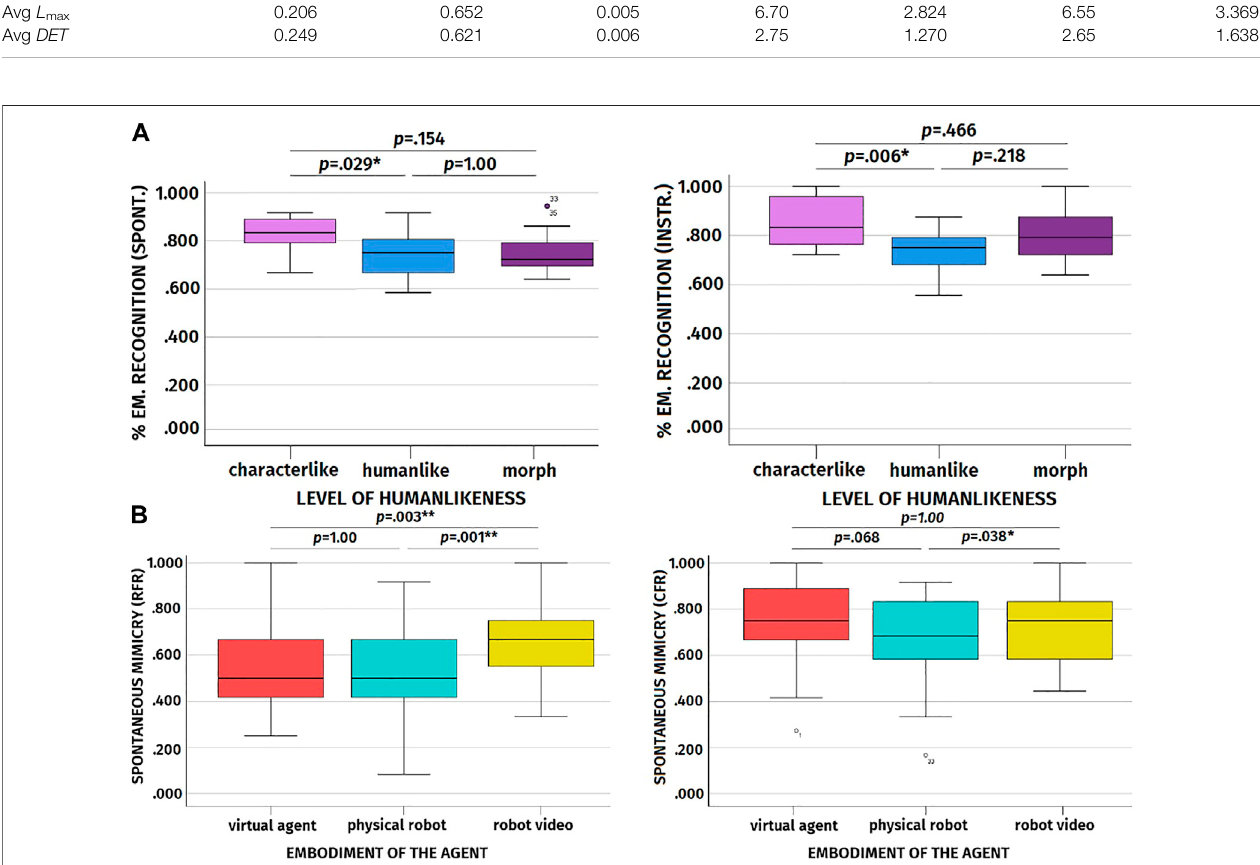
FIGURE 8 | (A) : Boxplots showing the effect of level of humanlikeness on the percentage of emotions correctly recognized for the spontaneous and instructed mimicry trials. (B) : Boxplots showing the effect of the agent ’ s embodiment on frequency of spontaneous facial mimicry for RFR and CFR.